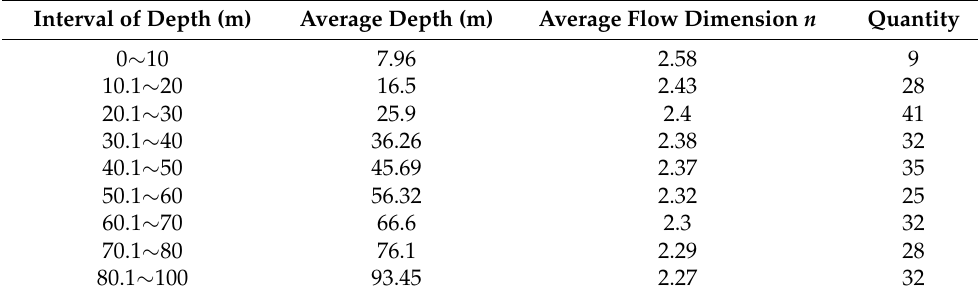
Table 7. Results for grouping depth